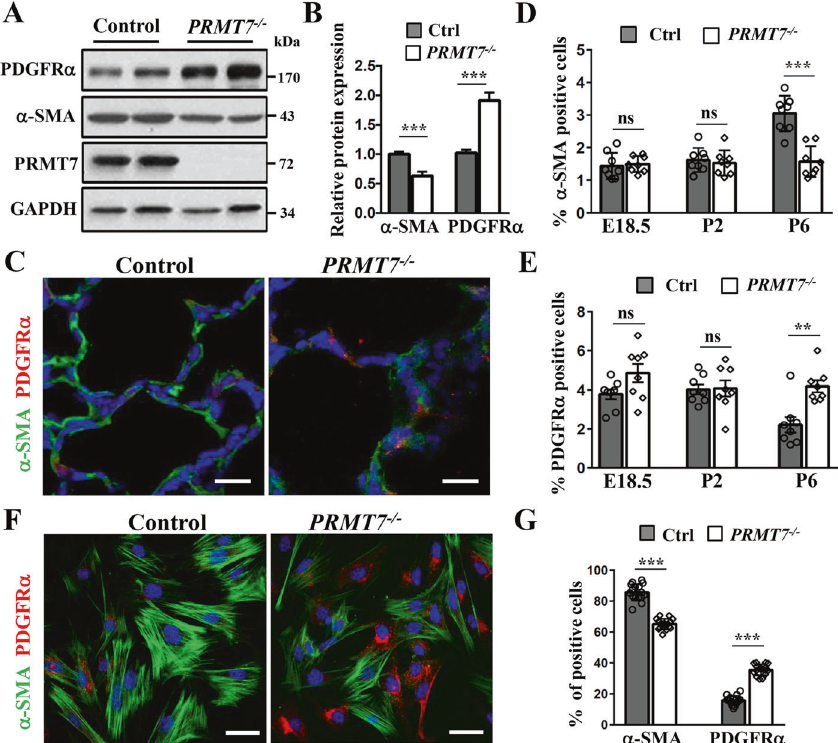
Fig. 4 Impaired fi broblast to myo fi broblast differentiation in PRMT7 − / − lungs. A Western blotting analysis showing the increased PDGFR α and decreased α -SMA expression levels in PRMT7 − / − lungs at P6. B Quantitative analysis of relative PDGFR α and α -SMA expression levels. The protein expression levels were normalized to GAPDH and the value for control protein expression level being set as 1. n = 4 biological replicates from three independent experiments. *** P < 0.001 (Student ’ s t -test). C Representative immuno fl uorescence images showing fewer α -SMA + cells and more PDGFR α + cells in PRMT7 − / − lungs. Scale bars: 50 μ m. D , E Quantitative analysis of α -SMA + ( D ) and PDGFR α + ( E ) cells in control and PRMT7 − / − lungs at E18.5, P2, and P6. Only the number of α -SMA + or PDGFR α + cells located within the alveolar region were calculated. Data were presented as mean ± SD. n = 8 mice for each phenotype and developmental stage. ns not signi fi cant,** P < 0.01, *** P < 0.001 (one-way ANOVA with Sidak ’ s test). F Representative double-immuno fl uorescence staining images of isolated myo fi broblasts (MYFs) by using α -SMA and PDGFR α antibodies. Scale bars: 20 μ m. G Quantitative analysis of α -SMA + and PDGFR α + cells in MYFs. n = 15 fi elds. *** P < 0.001 (one-way ANOVA with Sidak ’ s